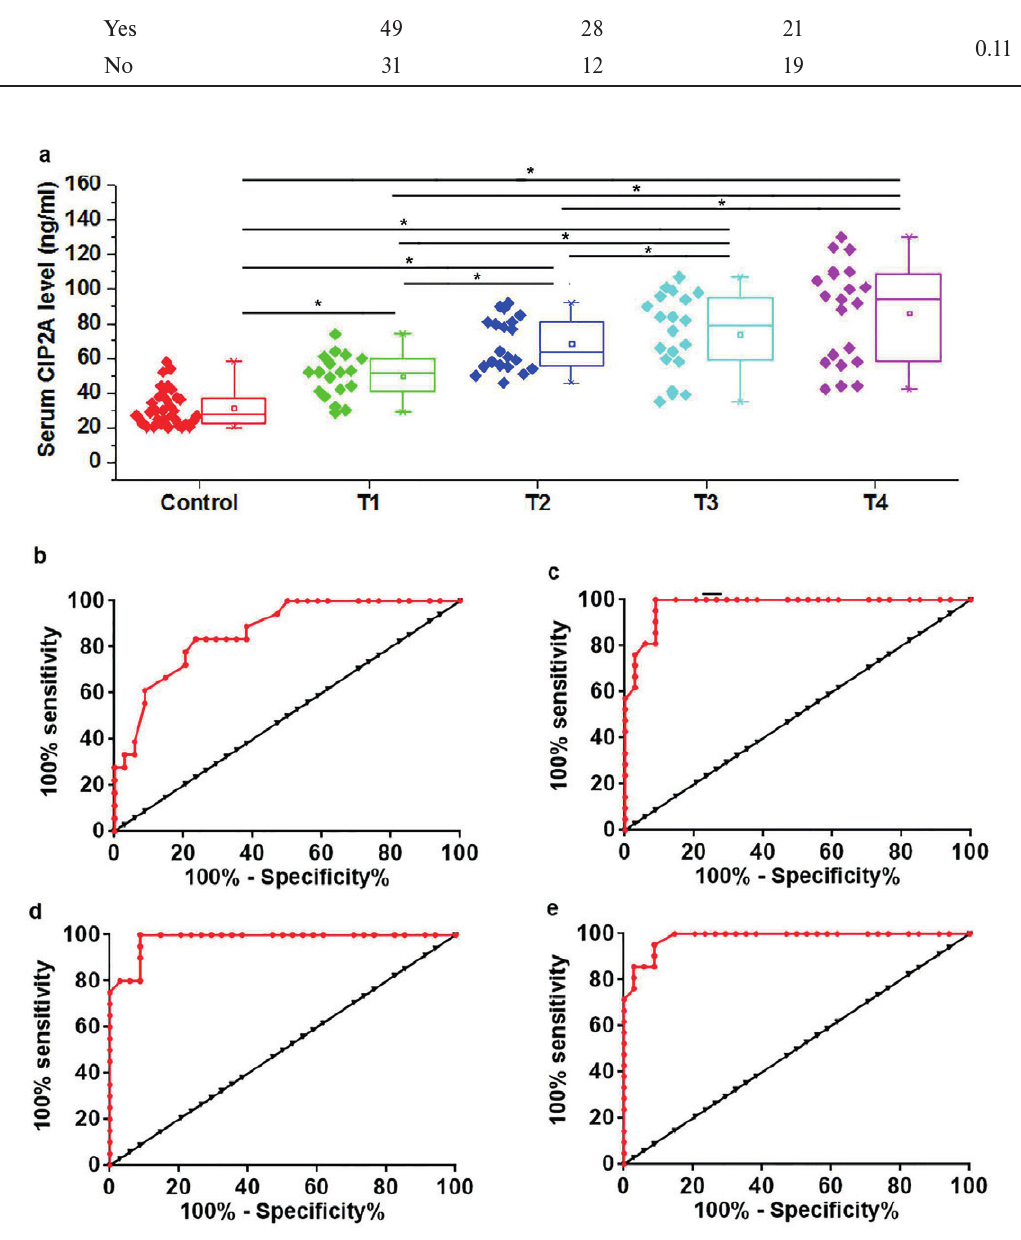
Fig. 2. Serum levels of CIP2A in renal clear cell carcinoma patients and its diagnostic values. a. Serum levels of CIP2A in patients with different stages of renal clear cell carcinoma; b. ROC curve analysis of the diagnostic value of serum CIP2A for patients with stage cT1 renal clear cell carcinoma; ROC curve analysis of the diagnostic value of serum CIP2A for patients with stage cT2 renal clear cell carcinoma; c. ROC curve analysis of the diagnostic value of serum CIP2A for patients with stage cT3 renal clear cell carcinoma; ROC curve analysis of the diagnostic value of serum CIP2A for patients with stage cT4 renal clear cell carcinoma. * P